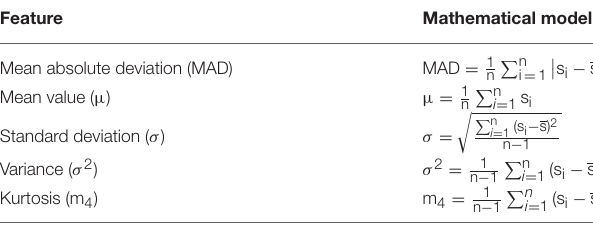
TABLE 1 | Time domain features used in